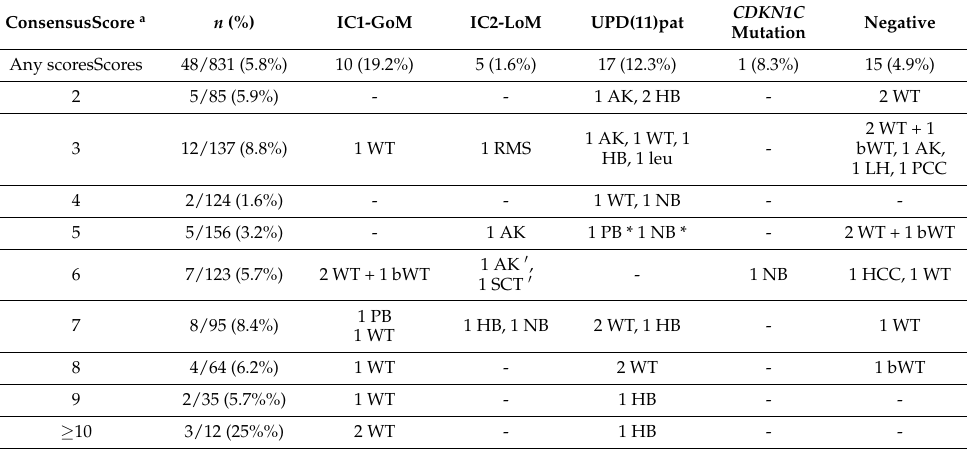
a The score in the table has been calculated without taking into account the points related to tumors; *, (cid:48) these tumors occurred in the same patient. Abbreviations: gain of methylation at imprinting center 1 (IC1-GoM), loss of methylation at imprinting center 2 (IC2-LoM), paternal uniparental disomy of the 11p15.5 chromosomal region (UPD(11)pat), pathogenic variants in CDKN1C (CDKN1C mutation), Wilms tumors (WT), bilateral Wilms tumors (bWT), hepatoblastomas (HB), adrenal carcinomas (AK), neuroblastomas (NB), pancreatoblastomas (PB), Sertoli cell tumor (SCT), hepatocarcinoma (HC), acute lymphoblastic leukemia (LLA), Hodgkin lymphoma (LH), 1 rhambdomyosarcoma (RMS), and 1 pheochromocytoma